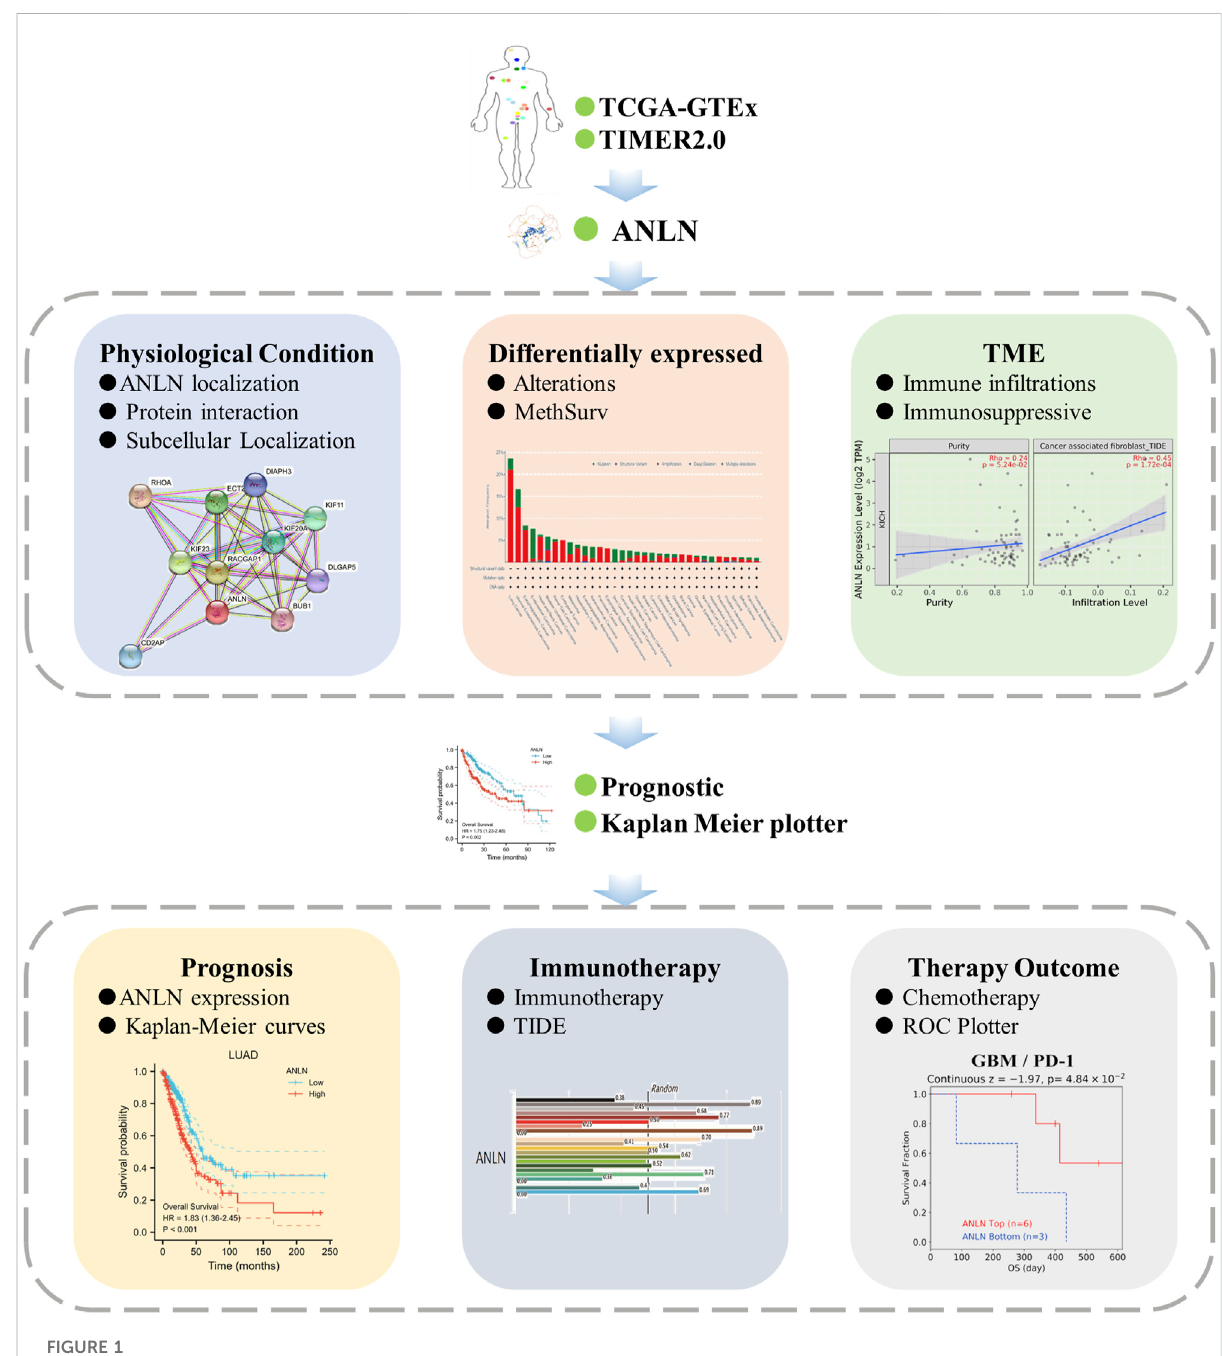
FIGURE 1 The work fl ow of the